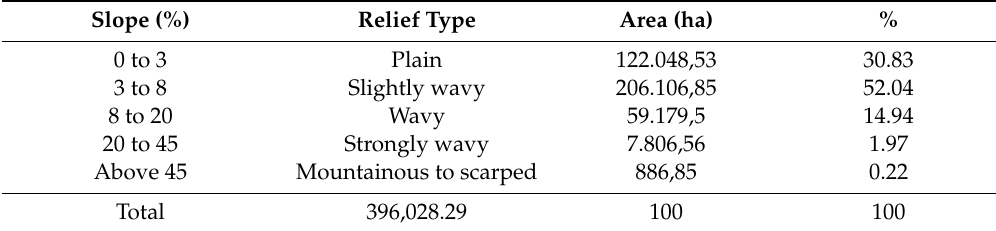
Figure 2. Slope map of the Pandeiros River basin. Table 2. Area of slope classes in the Pandeiros River basin.